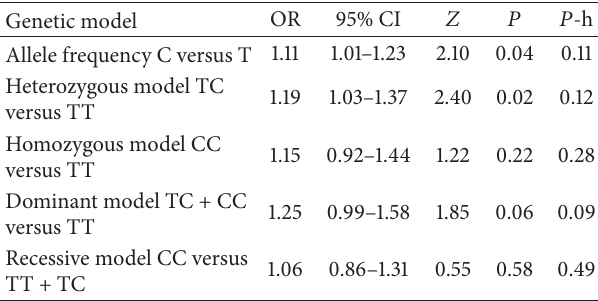
Table 3: Meta-analysis of the association between SNP miR-34b/c (T > C) rs4938723 and susceptibility to